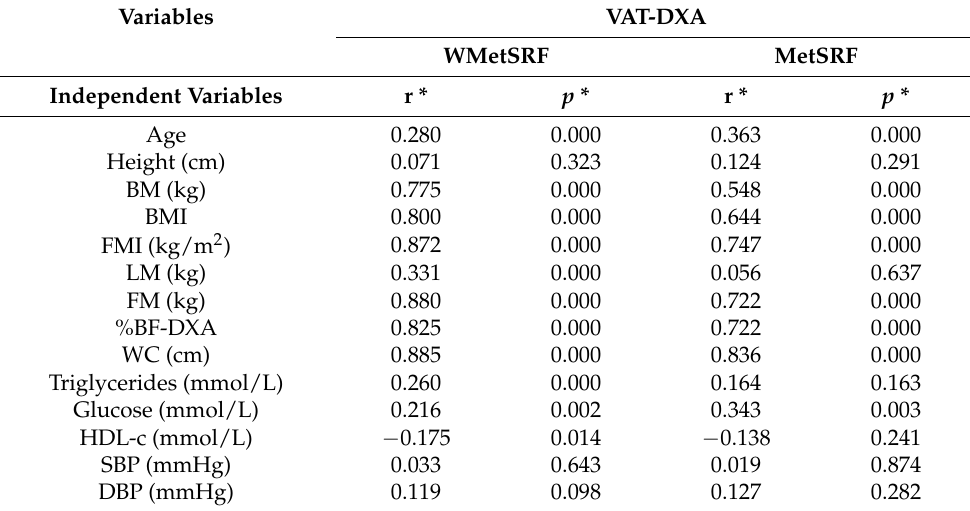
Table 2. Correlation between VAT-DXA and independent variables of militaries without MetS and with